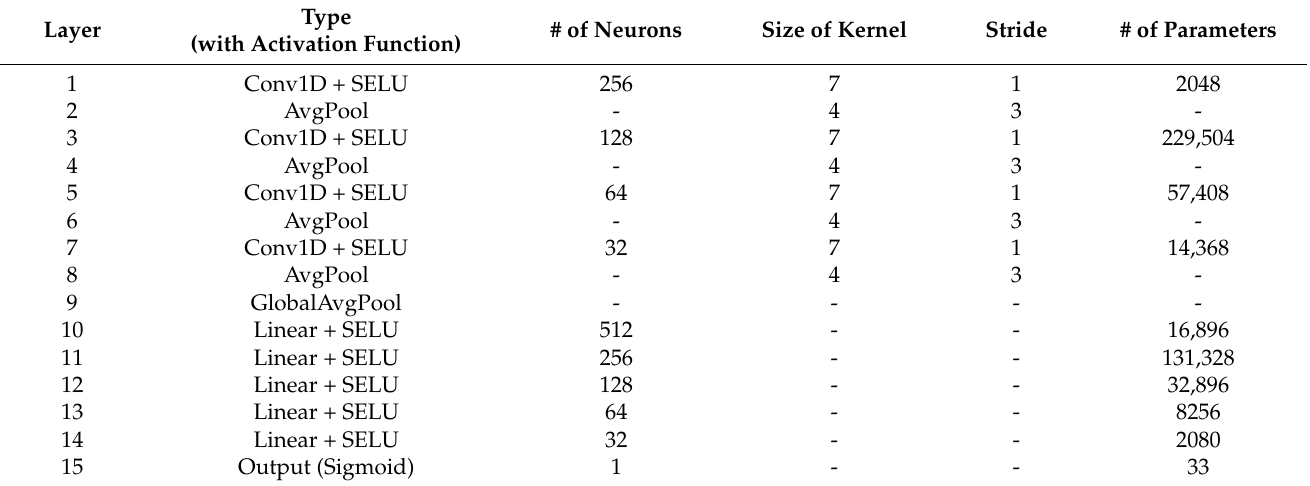
Table 3. Specification of detector.